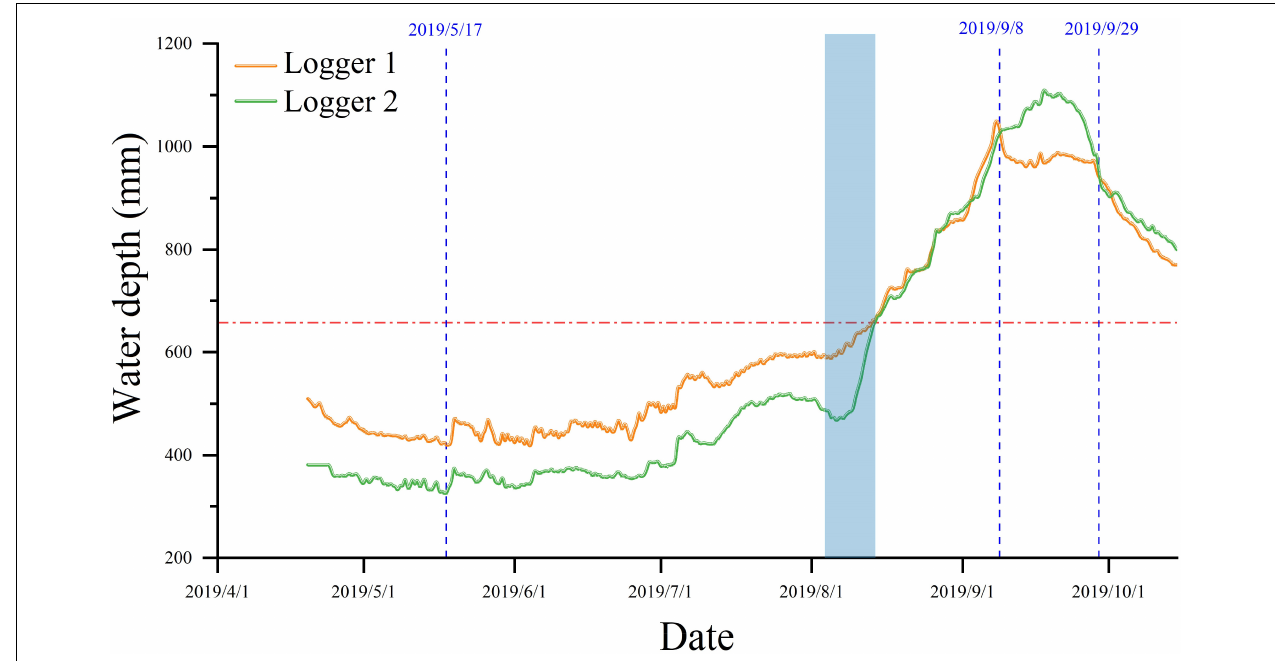
FIGURE 3 | Surface water level fluctuations under artificial